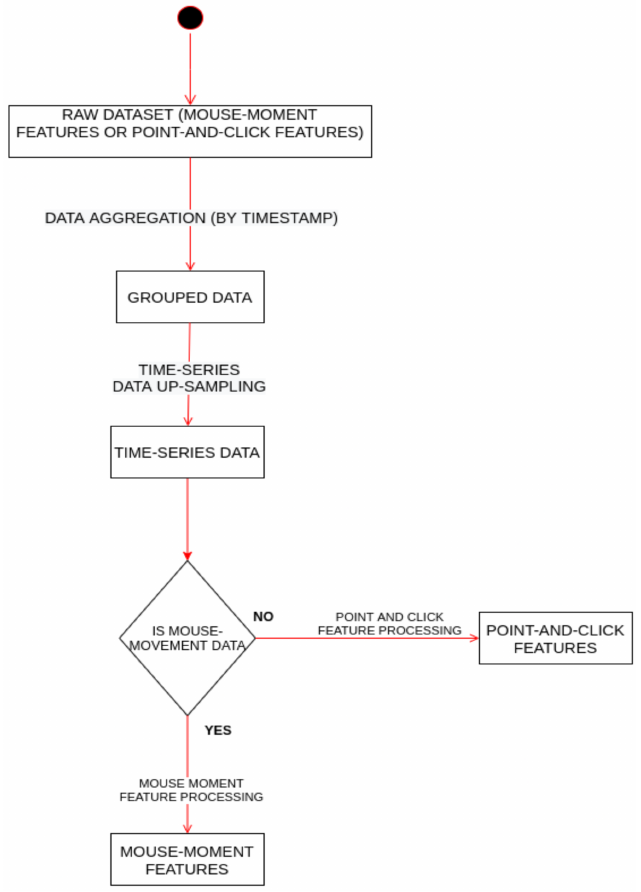
Figure 6. Activity diagram of data